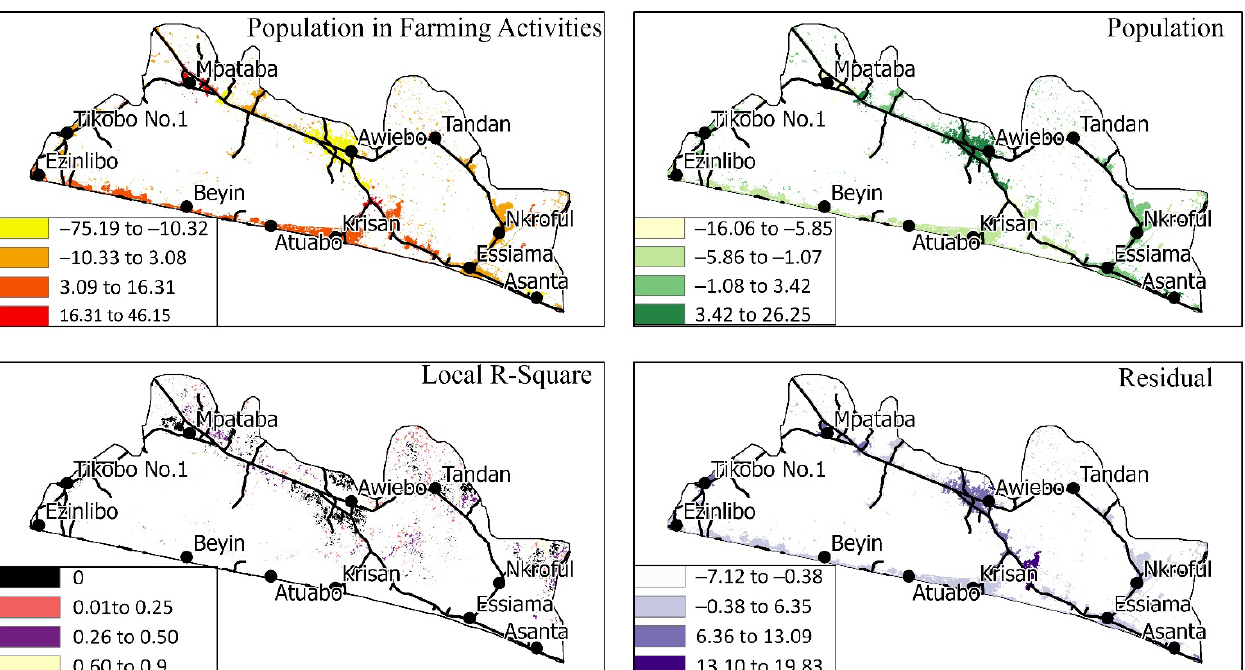
Figure 9. Results of geographically weighted regression showing spatial variations in the relationships between elevation, slope, distance from road, fishing population, farming population, total resident population and land use/land cover transitions to artificial/bare areas. Positive coefficients indicate the magnitude of spatial variation. Negative coefficients indicate no spatial correlations between the factor and transitions to artificial/bare areas.